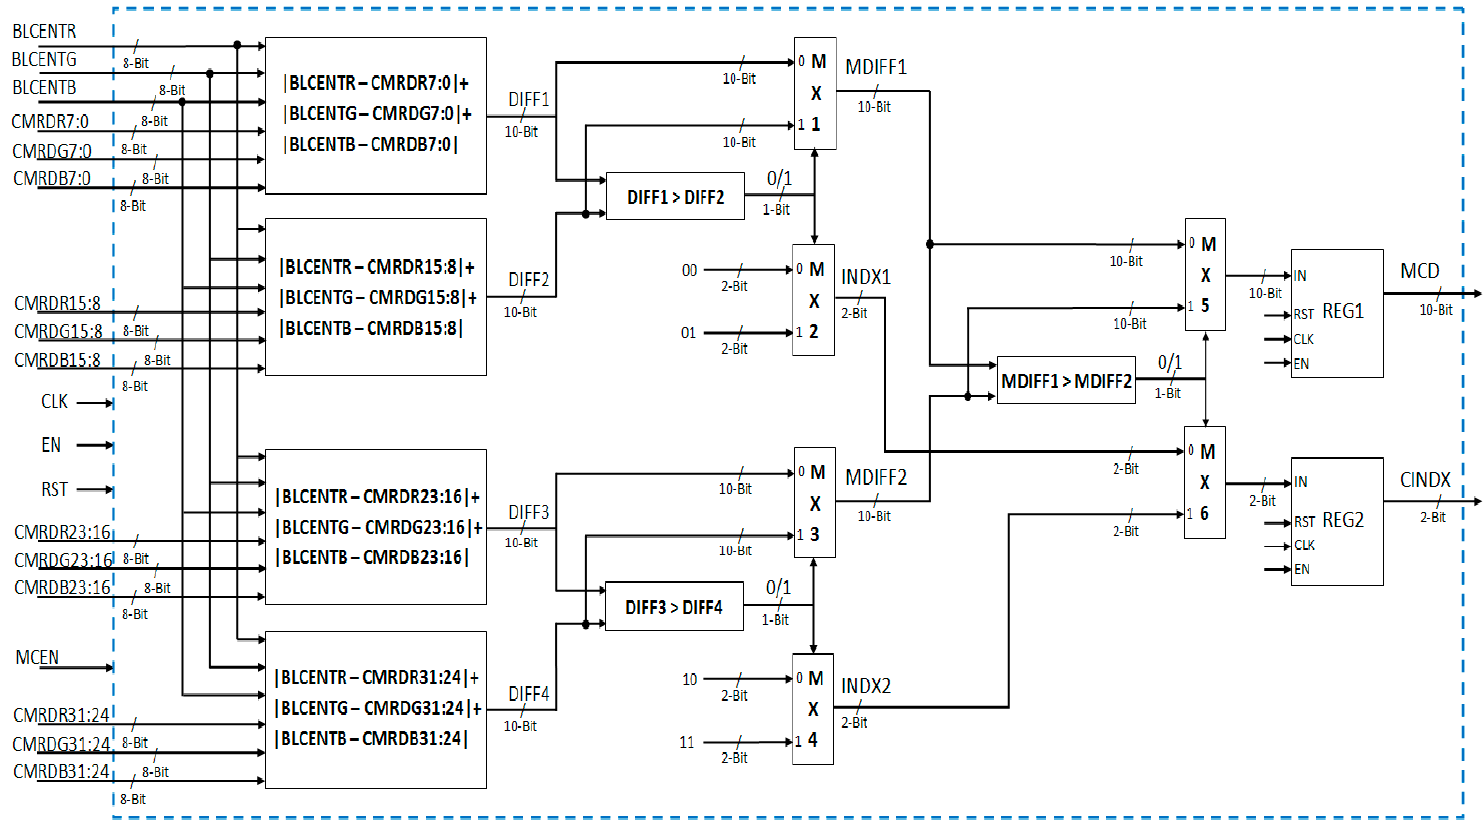
Figure 14. Proposed VLSI architecture for minimum centroid difference computation